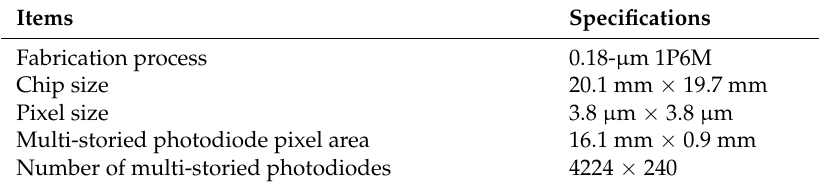
Table 1. Design specifications of the demonstrated multi-storied photodiode CMOS image sensor.